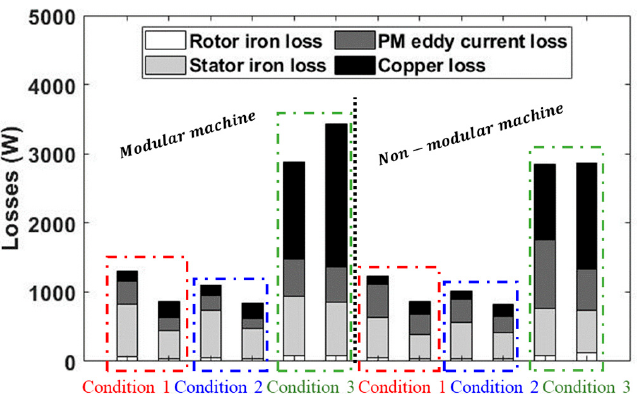
Figure 17. Losses (including stator and rotor iron losses, and PM eddy current loss) of both investigated machines under different operating conditions. For each load condition, the left-hand bar reflects the losses obtained by using the EM-only model and the right-hand bar reflects the losses obtained by using the EM-thermal coupled model.